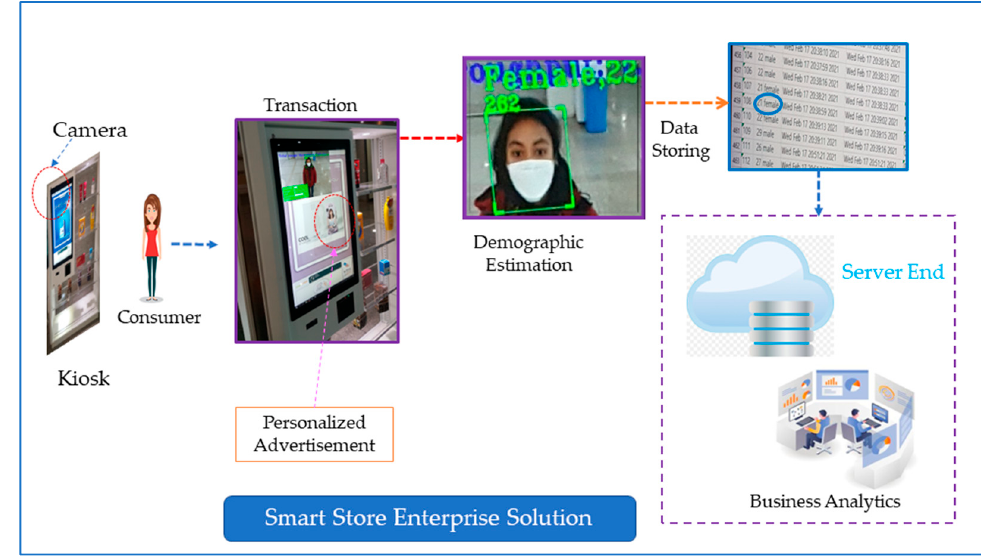
Figure 1. Masked face age estimation system for smart store customer relationship management.